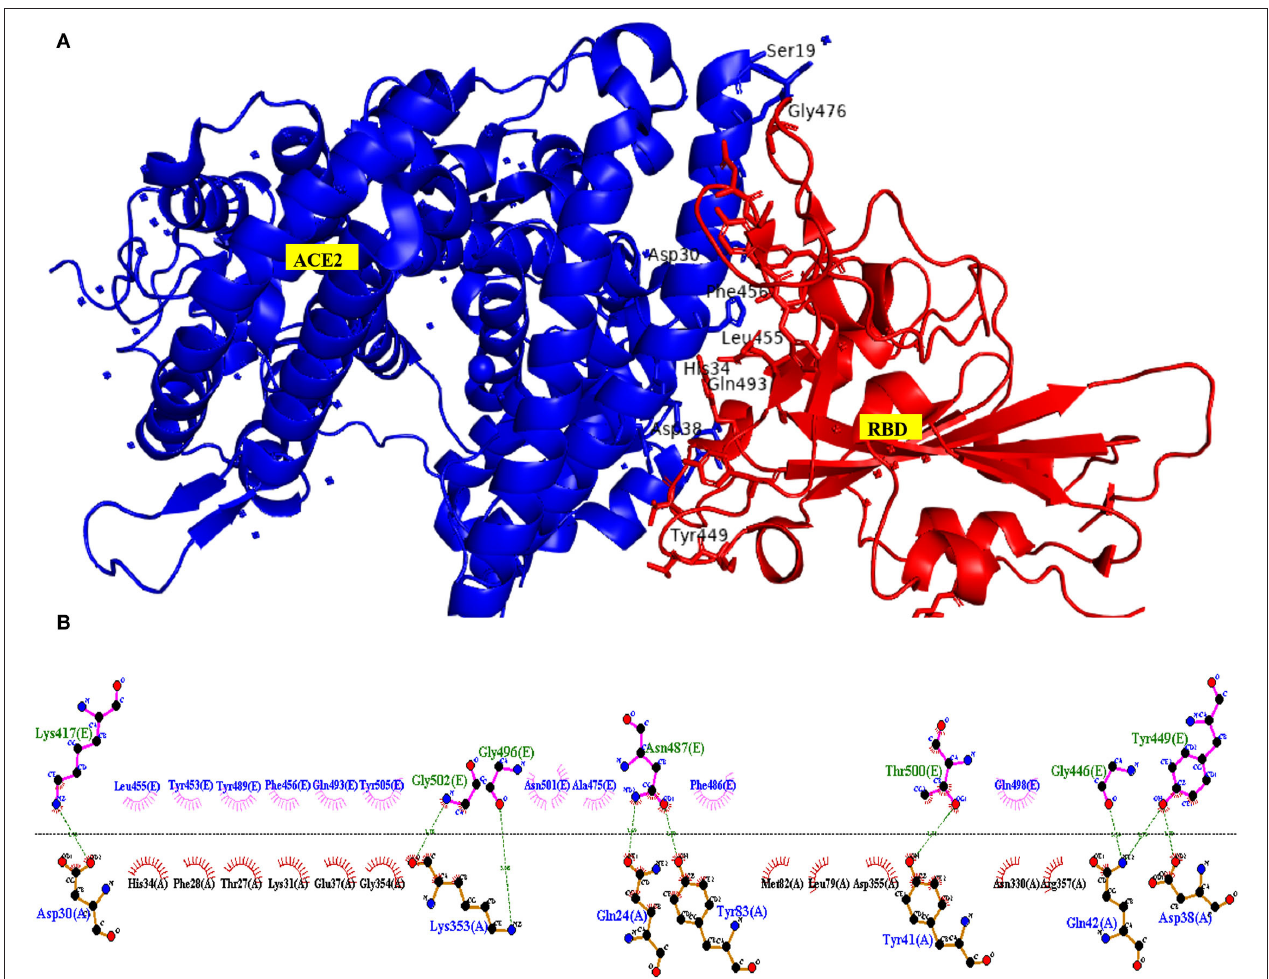
FIGURE 8 | Interacting amino acid residues between the Angiotensin-Converting Enzyme-2 (ACE2) receptor and SARS-COV2 Receptor Binding Domain (RBD) (A) and the 2D interaction plot (B) , visualized using PyMol and